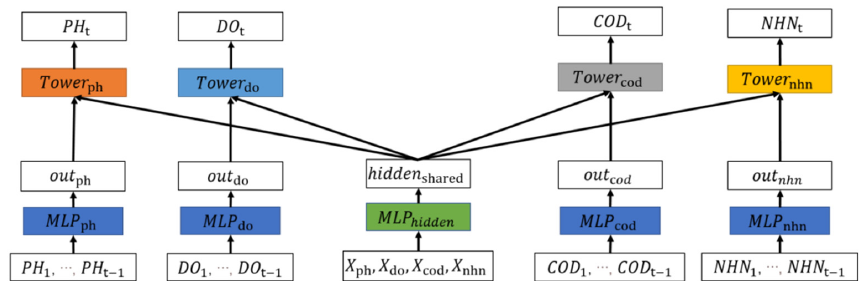
Figure 3. Soft parameter sharing structure of multi-indicator water quality prediction. Algorithm 2: Multi-indicator water quality prediction based on soft parameter sharing multi-task learning